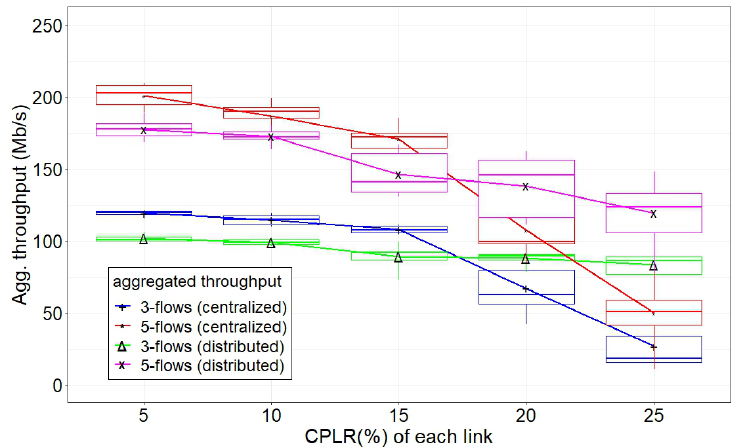
Figure 4. Data plane performance metric (aggregated throughput) comparison between centralized and distributed operations, during unreliable control plane conditions in a 9-node grid network.